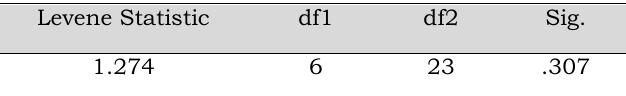
Table 2. Homogeneity of Variances Levene Statistic